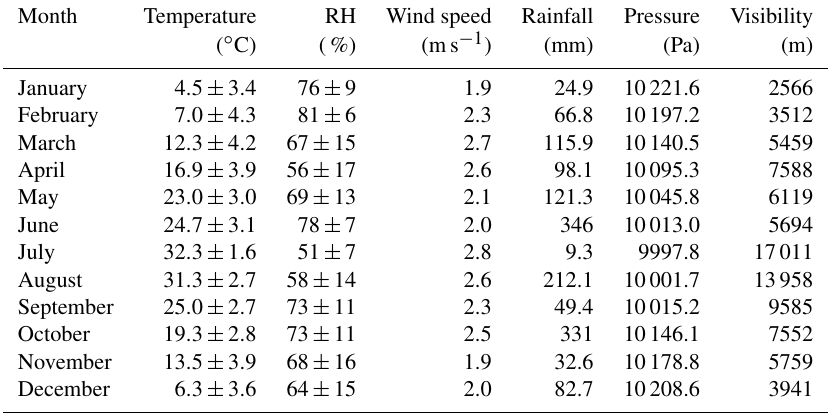
Table 1. Statistics of general meteorological parameters at NRCS for the period of January–December 2013 ∗ . Month Temperature RH Wind speed Rainfall Pressure Visibility ( ◦ C) (%) (ms − 1 ) (mm) (Pa) (m)